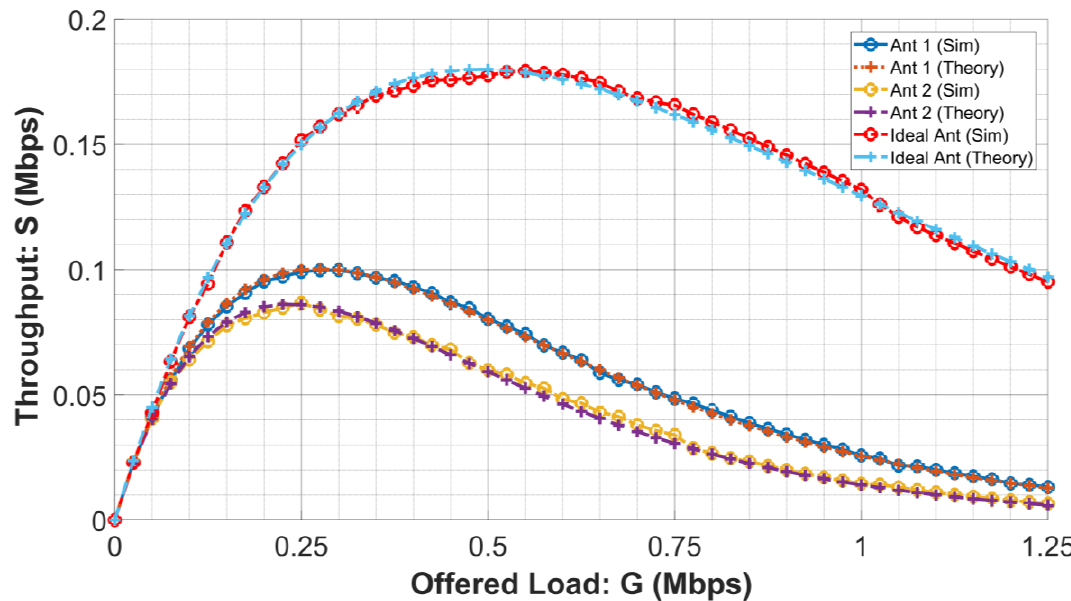
Figure 5. Throughput comparison of different antenna patterns with the DH-Aloha protocol with 𝑀 = 4 .